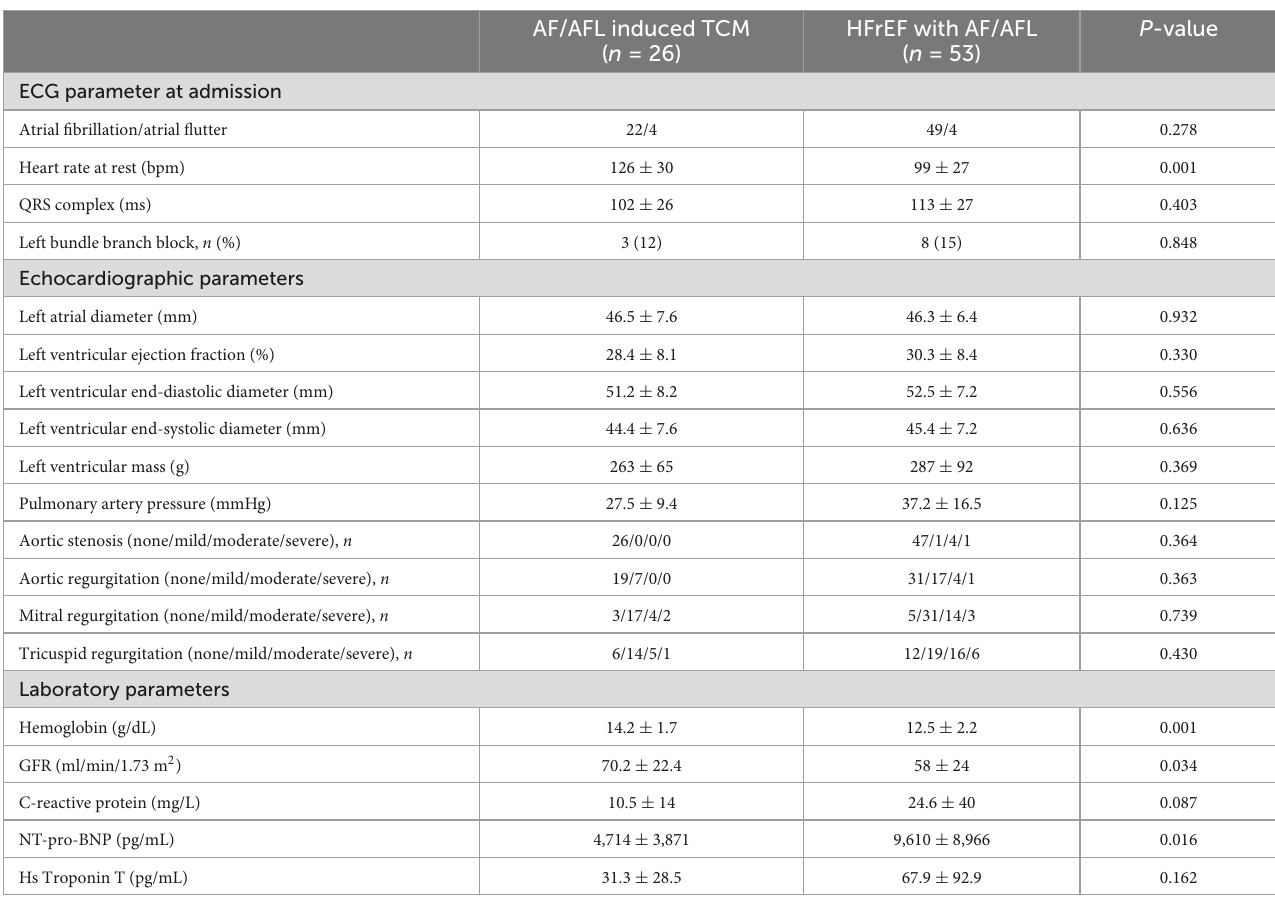
TABLE 2 Electrocardiographic, echocardiographic, and laboratory parameters of study patients ( n = 79).